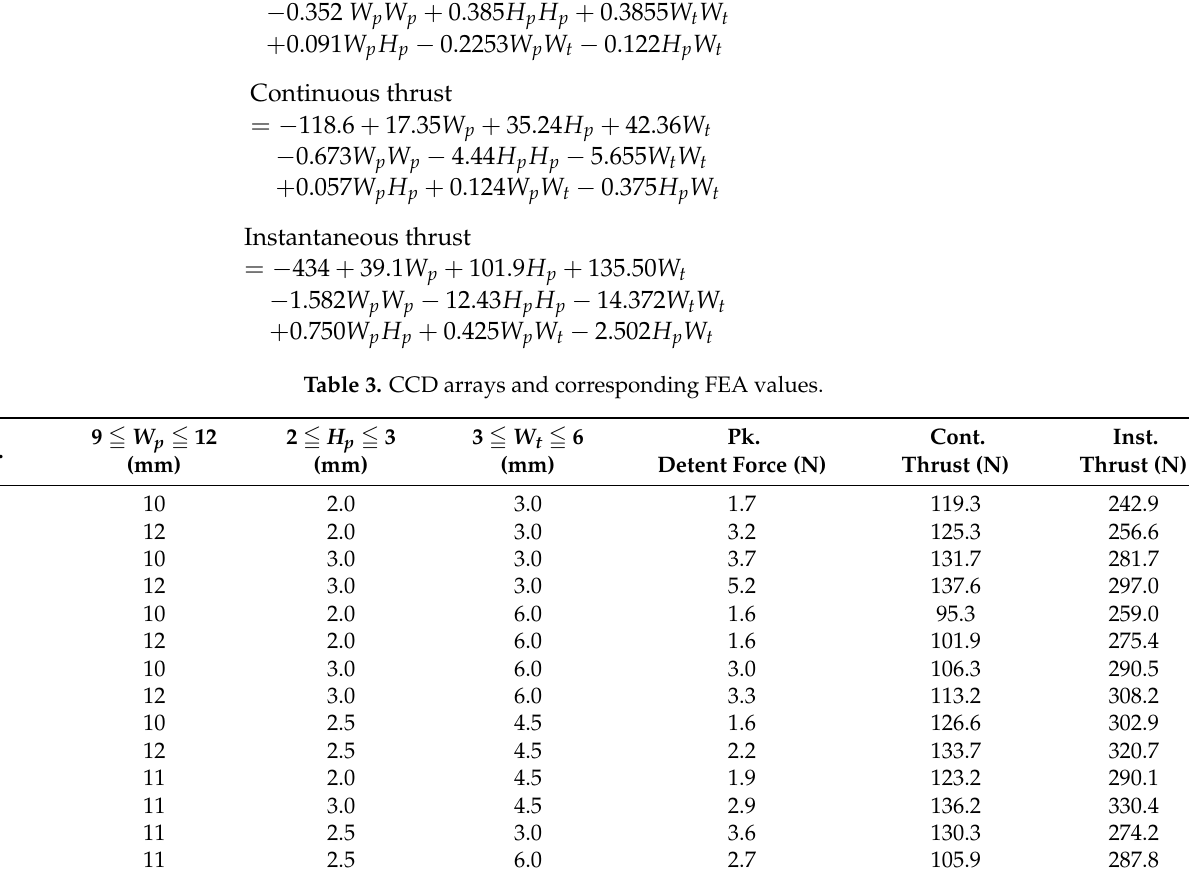
Table 4 lists several combinational optimization scenarios using the response models.